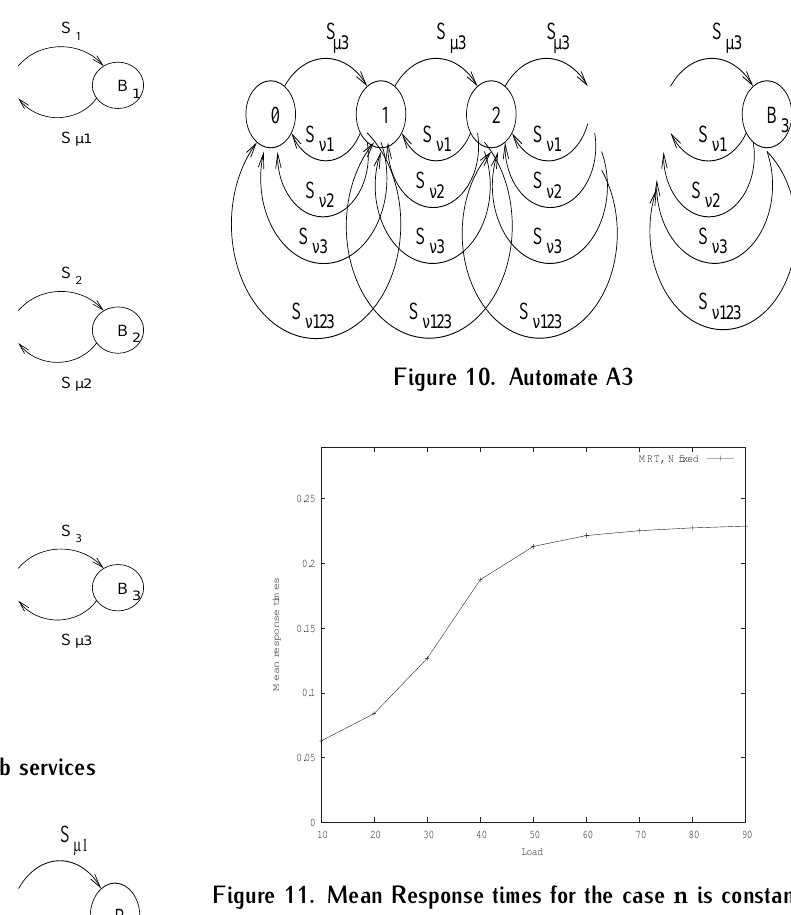
Figure 8. Automate A1